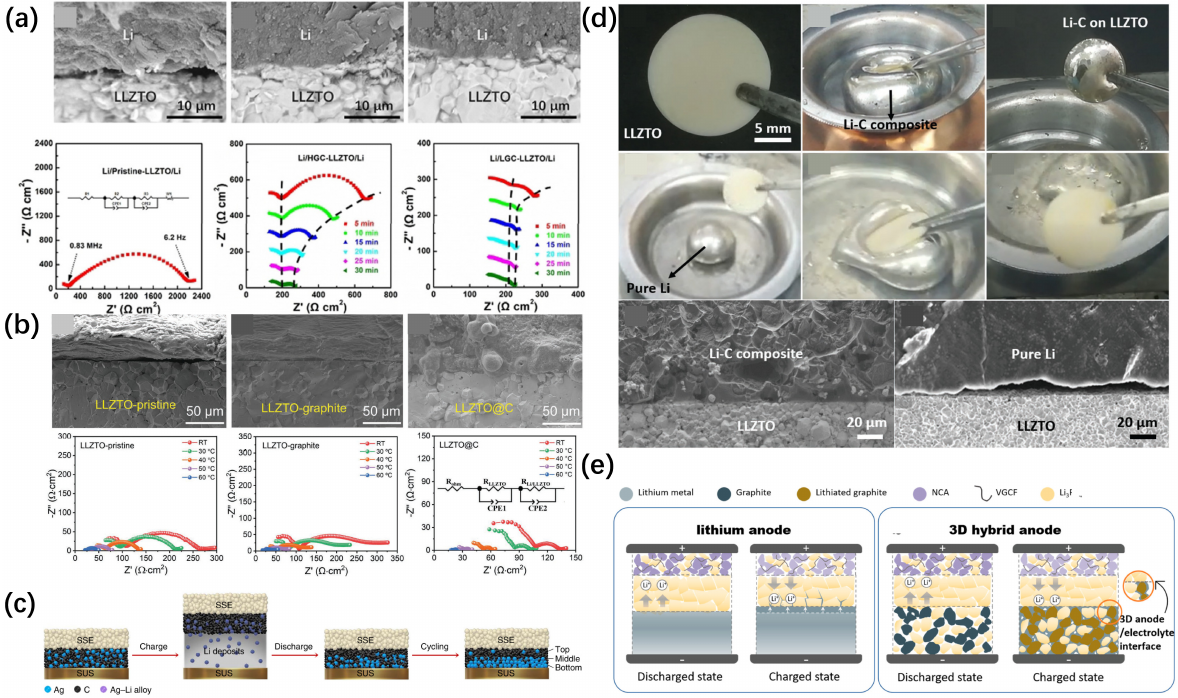
Figure 11. ( a ) Amorphous low graphitized carbon stabilized Li/LLZTO interface [134]. ( b ) Li/LLZTO interface stabilized by the porous hard carbon layer [135]. ( c ) Schematic illustration of the role of the Ag-C nanocomposite layer on the current collector to stabilize the Li coating during charging and discharging [136]. ( d ) Comparison of the interfacial behavior of LLZTO with pure Li and Li-C [137]. ( e ) Schematic illustration of the deposition process on Li metal and 3D composite anode in an all-solid-state Li metal battery